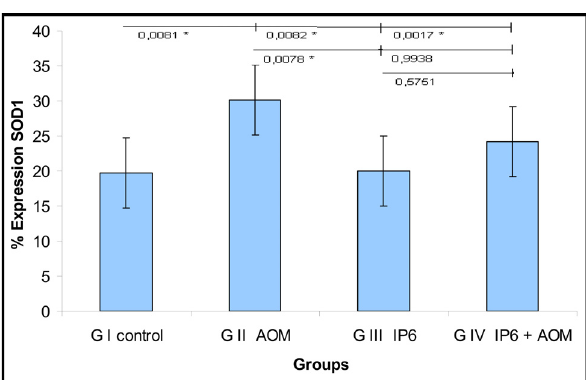
FIGURE 3 - Results imunohistochemistry. *Significance p< 0,05